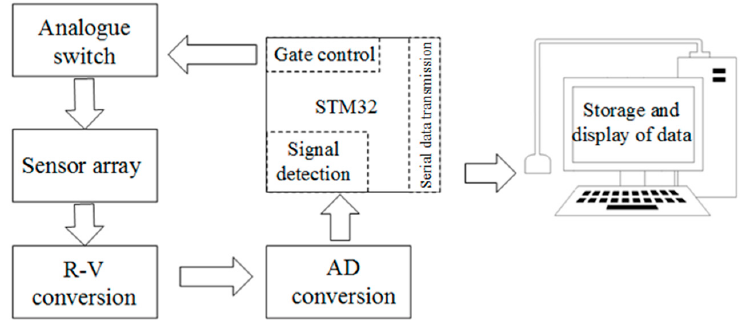
Figure 5. Block diagram of the data acquisition method.